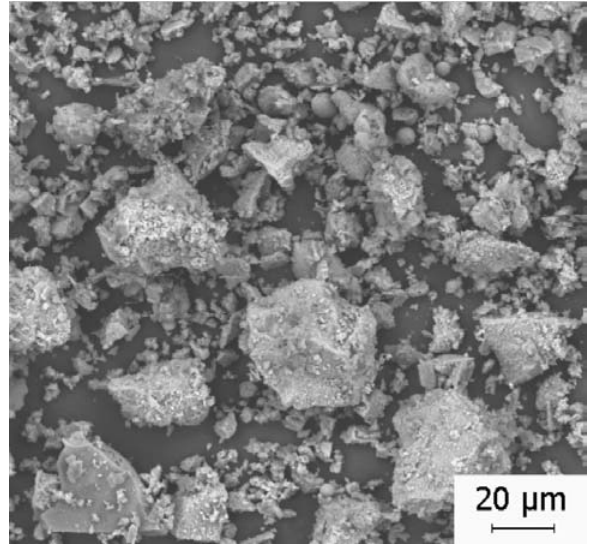
Figure 3. SEM micrograph of the morphology of bottom ash waste